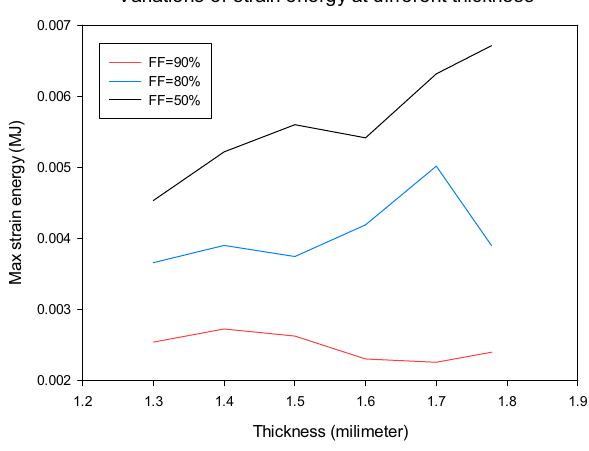
Fig. 25 The variation of strain energy at different thickness